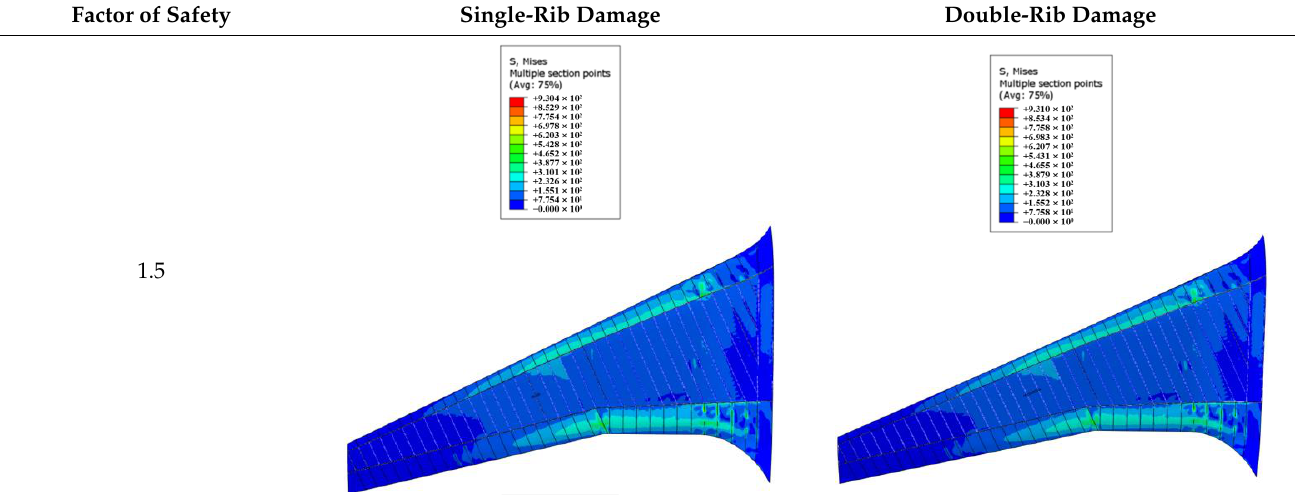
Figure 11. Location of stress concentration in the lower skin component at F.o.S. = 2 (single-rib dam- age on the left, double-rib damage on the right). The point of contact between the upper skin and the rib components near the root of the wing was found to have the largest in-plane strain, with high values of 0.0080 at the standard factor of safety 1.5, 0.01156 at the factor of safety 2, 0.01492 at the factor of safety 2.5, and 0.01830 at the factor of safety 3 in the model with the smaller cut, as illustrated in Table 16. The double-rib damage model converts these numbers to 0.0080, 0.01156, 0.01492, and 0.01830, respectively. It can be noticed that the strain values and distribution are the same even if the cut is larger. The strain distribution was significantly affected by the presence of the stringers and ribs, which causes the smooth transition to be disrupted by discontinuities; this disruption is not more noticeable in the upper section, which is subjected to compression. On the other hand, the lower section of the wing has a larger in-plane principal strain distributed over a larger section.